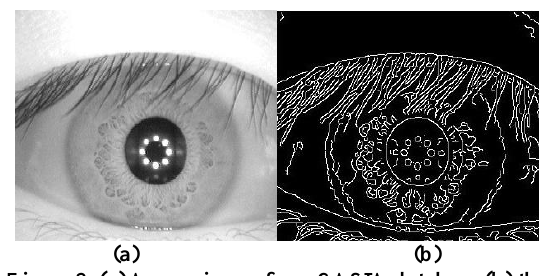
Figure 2. (a) An eye image from CASIA database (b) the results of pre-processing performed.